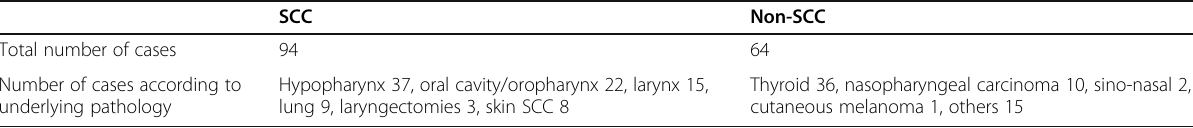
Table 1 Distribution of pathologies among two groups of patients SCC Non-SCC Total number of cases 94 64 Number of cases according to underlying pathology